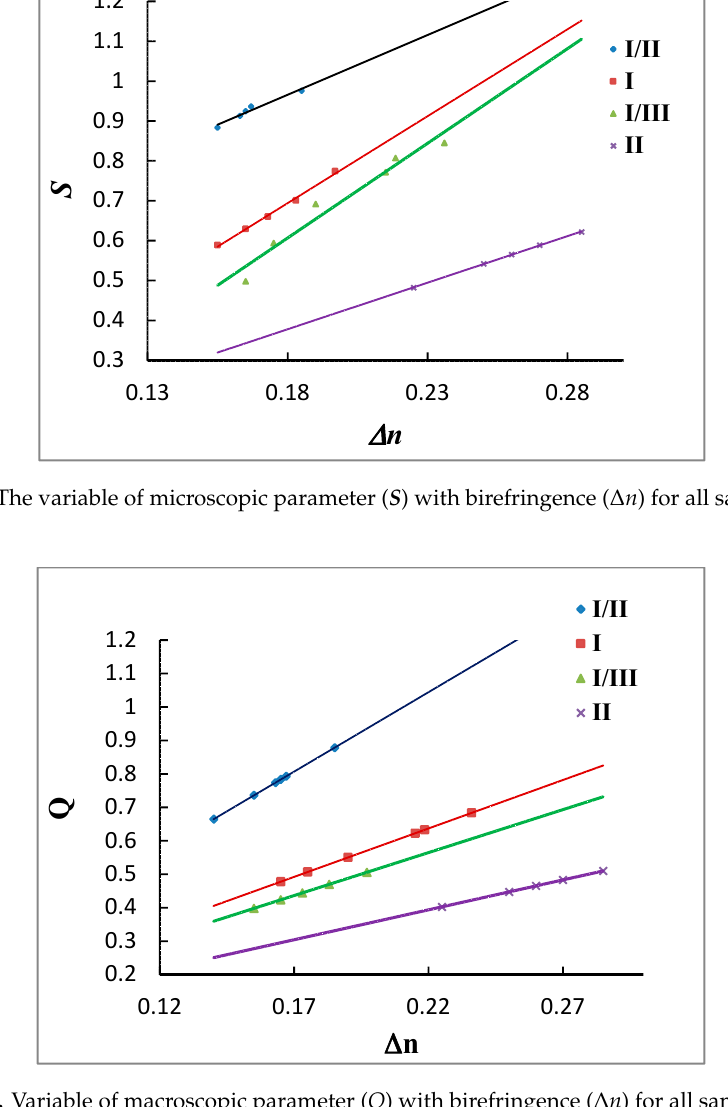
Figure 15. Variable of macroscopic parameter ( Q ) with birefringence ( ∆ n ) for all samples